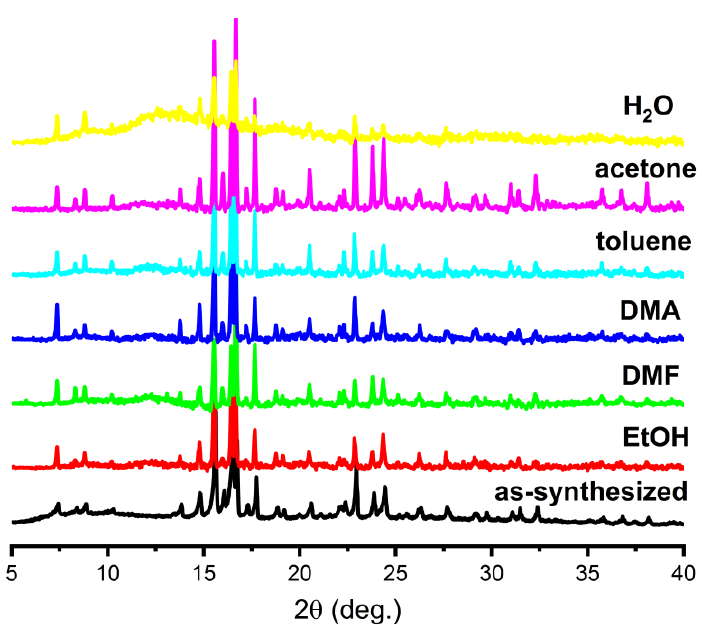
Figure 2. PXRD patterns of MOF 1 upon soaking in different solvents for 24 h at room temperature.